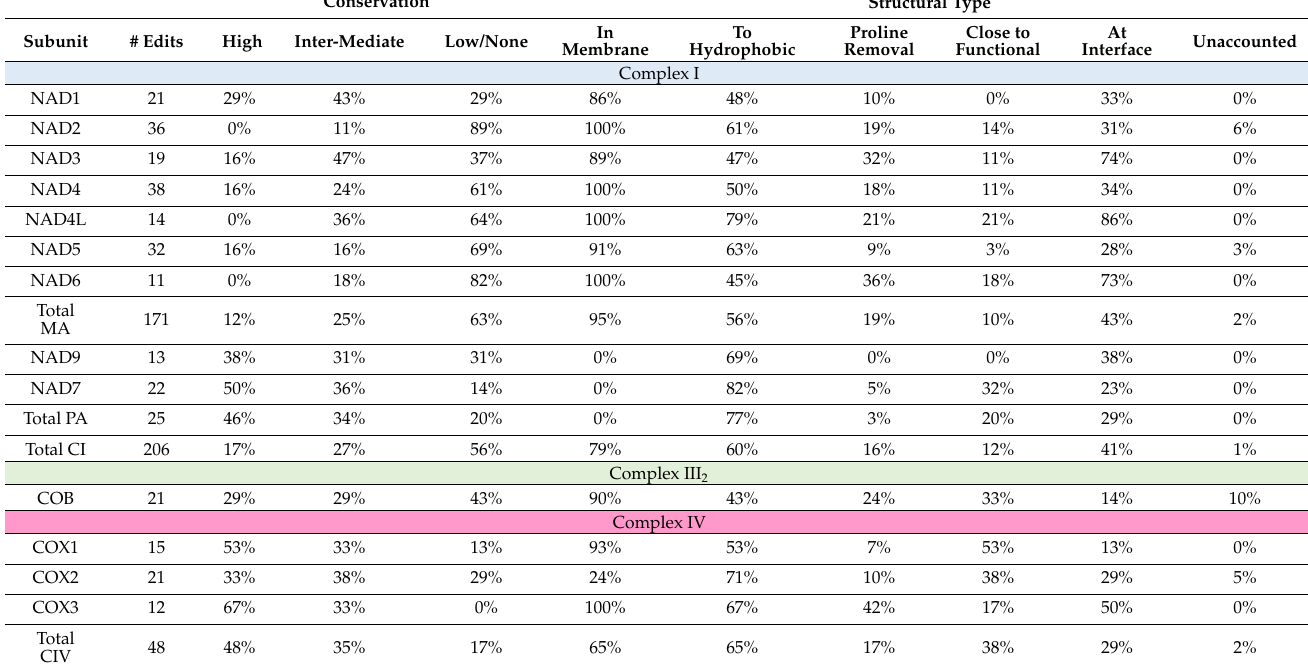
Table 1. Summary of the characteristics of RNA editing positions in plant respiratory complex I, complex III 2 and complex IV. RNA-editing positions were collated from 17 plant species. Structural characteristics were assessed based on the homologous position of the edit in the high-resolution structures of A. thaliana (complex I, PDB: 7AR8) or V. radiata (complex III 2 , PDB: 7JRG; complex IV, PDB: 7GRO). Full details available in Supplementary File S1. CI, complex I; CIV, complex IV; MA, membrane arm; PA, peripheral